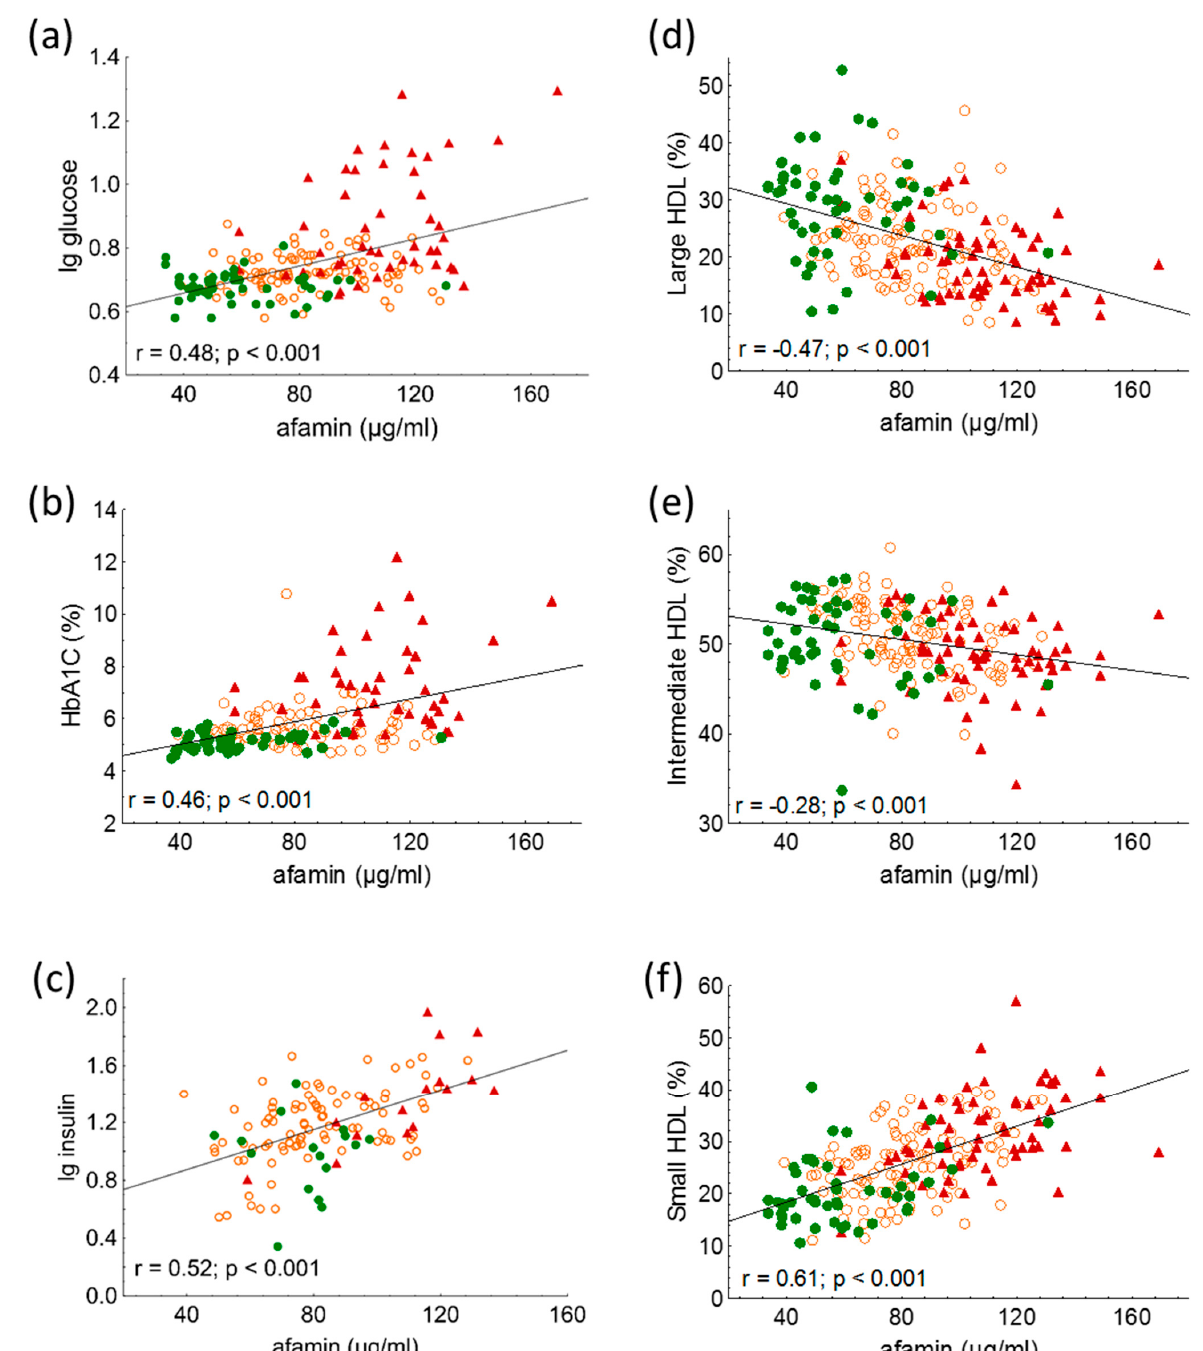
Figure 2. Correlations between ( a ) lg glucose; ( b ) HbA1C; ( c ) lg insulin; ( d ) percentage of large high- density lipoprotein (HDL) subfraction (HDL-1-3); ( e ) percentage of intermediate HDL subfraction (HDL-4-7); and ( f ) percentage of small HDL subfraction (HDL-8-10) and serum afamin in healthy lean subjects (controls; green color), non-diabetic obese patients (NDO; orange color), and patients with type 2 diabetes mellitus (T2DM; red color). Afamin concentrations were quantified from peripheral blood serum samples with enzyme linked immunosorbent assays, and HDL subfractions were distributed by Lipoprint gel electrophoresis. The percentage of IDL subfractions and mean LDL size correlated negatively with serum afamin (r = − 0.29; <0.001 and r = − 0.29; p < 0.001, respectively); while the percentage of large LDL and small-dense LDL subfractions correlated positively with afamin (r =